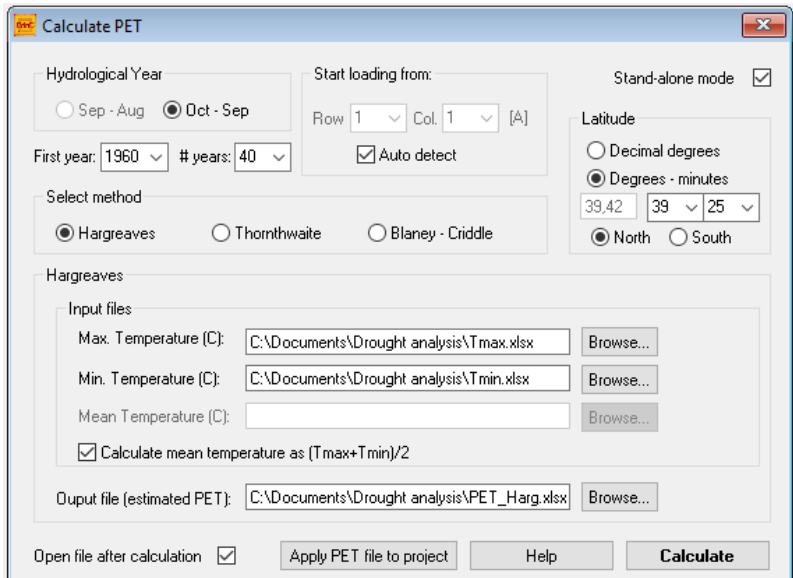
Figure 3. The PET calculation module of DrinC software.